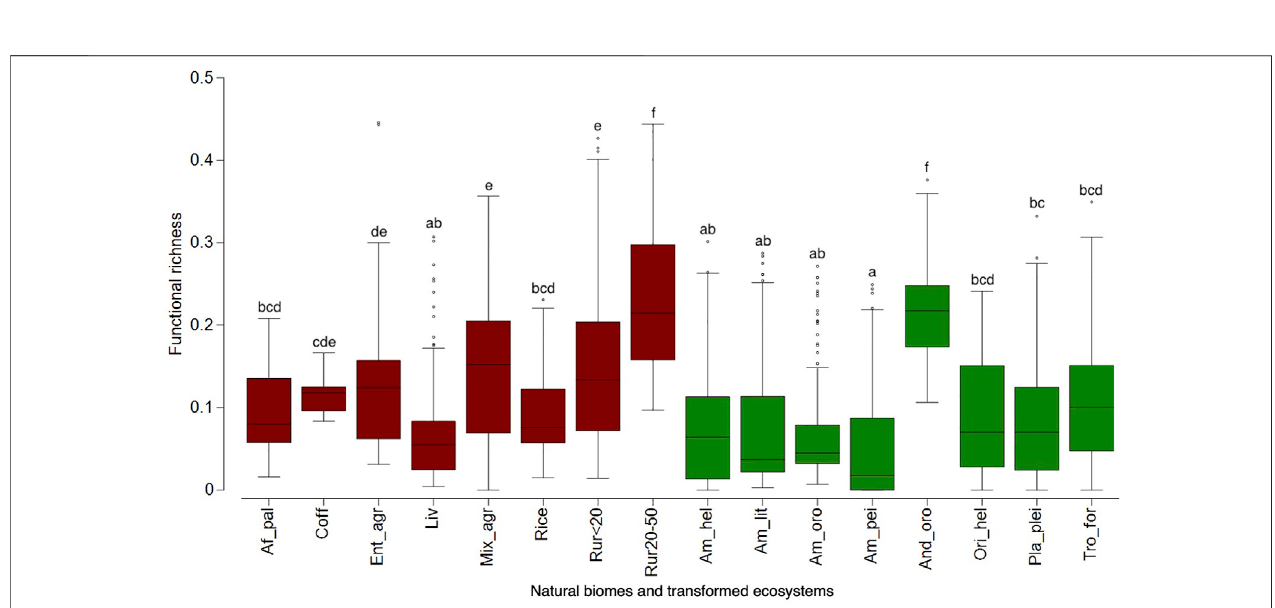
FIGURE1| Boxplotsshowingtaxonomicrichness among biomes/ecosystemsand land-use type (natural vs.transformed) ofexoticspeciesintheOrinocoregion. Different letters indicate signi fi cant differences based on the Bonferroni test. For biomes/ecosystems see Table 1 . Red: transformed ecosystems and green: natural biomes.